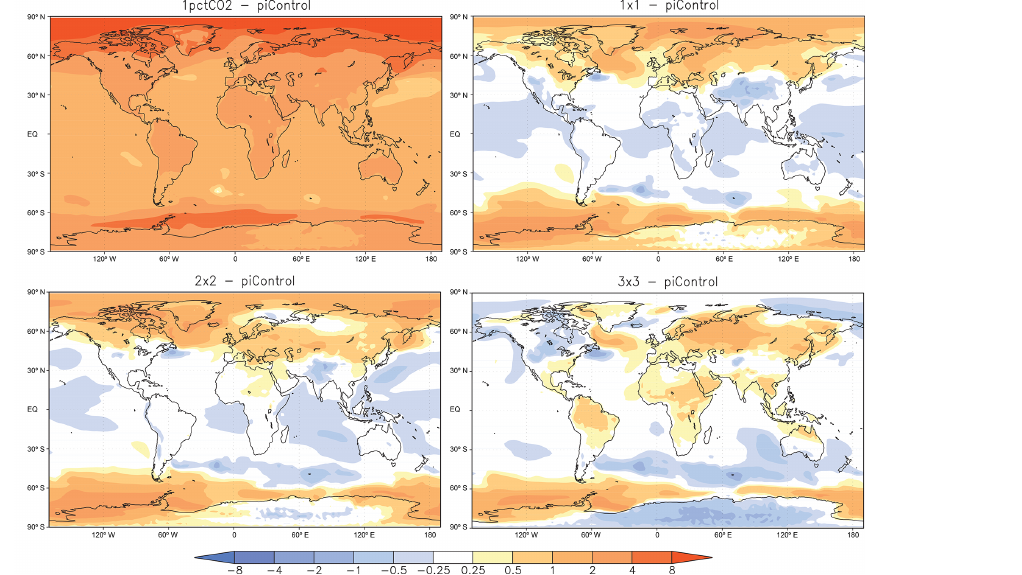
Figure 19. Maps of temperature change from the preindustrial control simulation ( ◦ C) for the 3 × 3 design case and its sub-cases in the design model. All panels are averages over the last 10 years of a 70-year